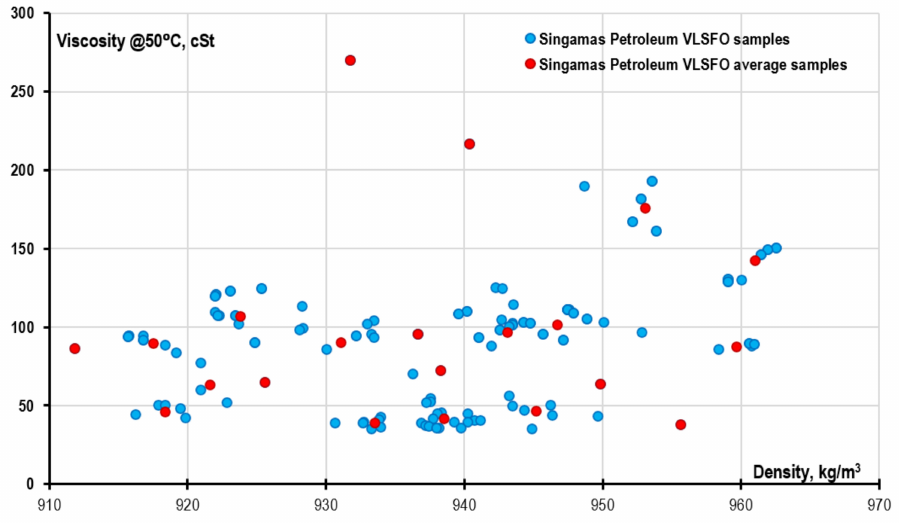
Figure 10. Singamas Petroleum average batches